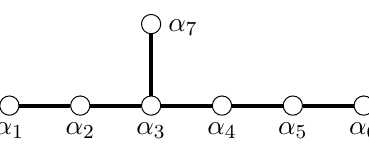
Figure 4 . Our convention for the labeling of the simple roots of E 7